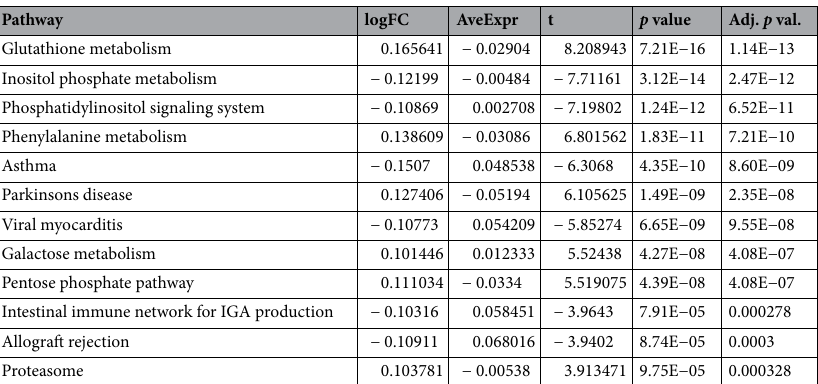
Table 2. The activation states of biological pathways in distinct m 6 A modification patterns by GSVA enrichment analysis (A vs. B). AveExpr: average expression; adj. p . val: adjust p value.